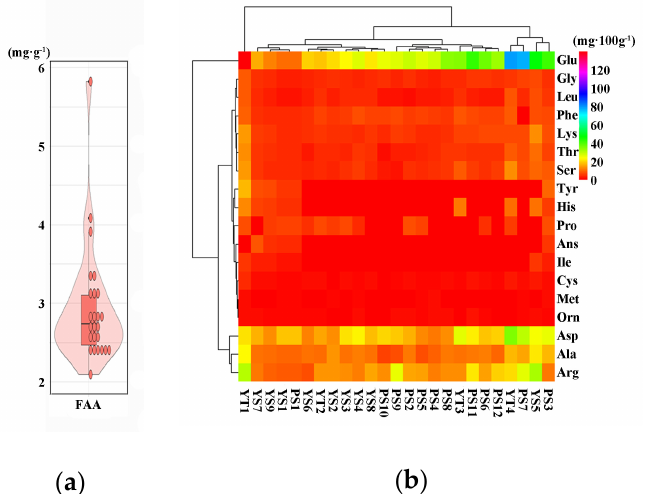
Figure 3. The cultivar variation in total free amino acids content ( a ) and amino acid composition ( b ).